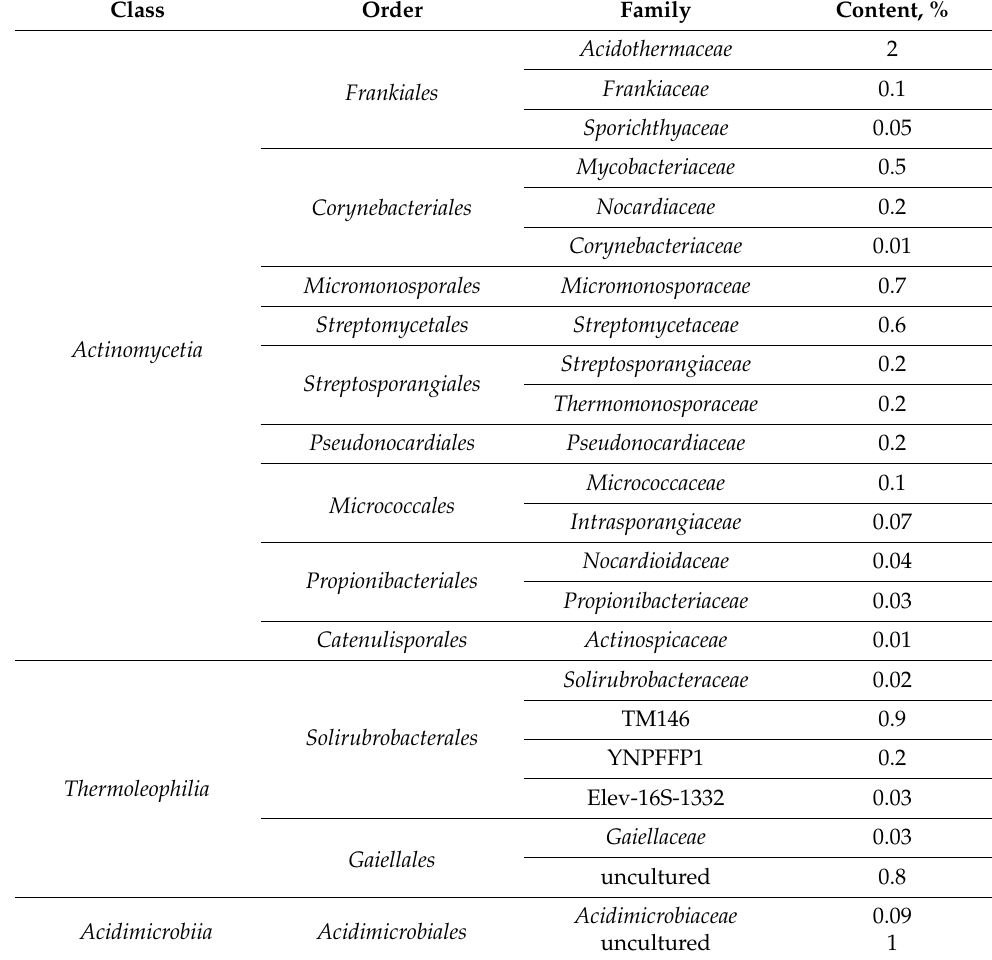
Table 4. Representation of taxa of the phylum Actinobacteriota in alluvial brown